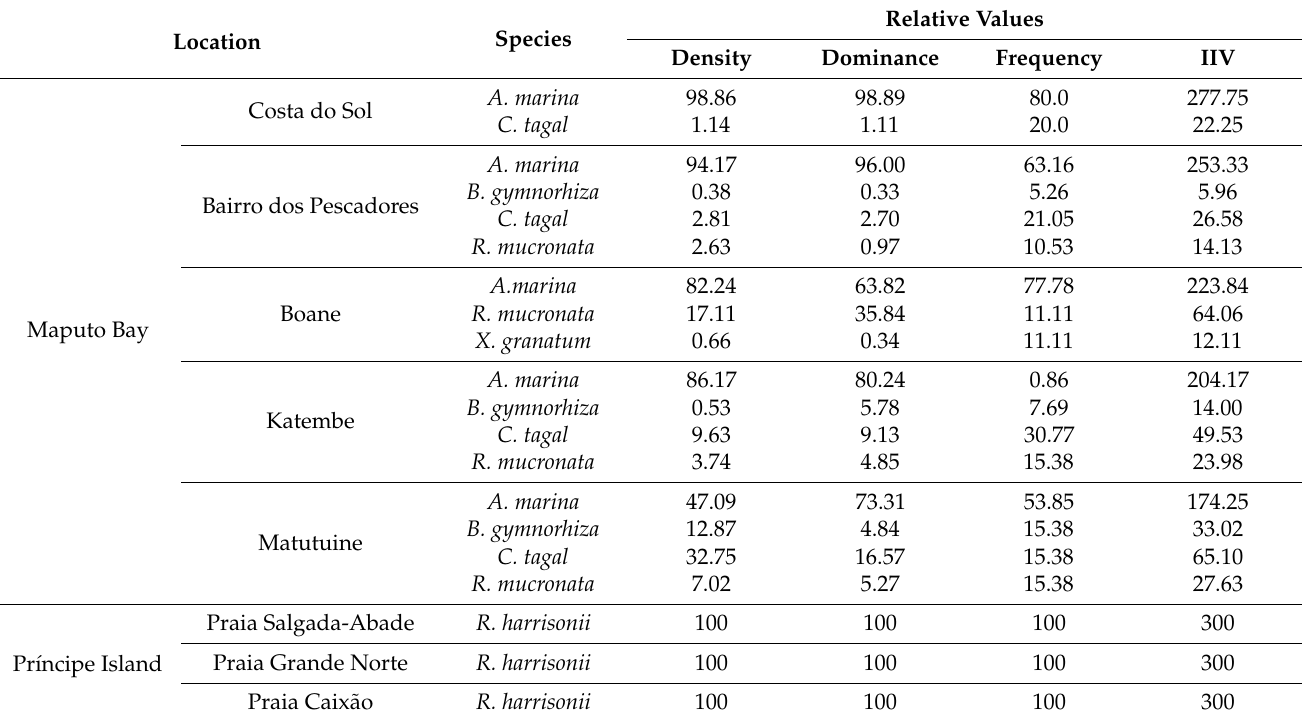
Table 2. Importance Index Values (IIV), showing the importance of each species within the forests sampled in specific